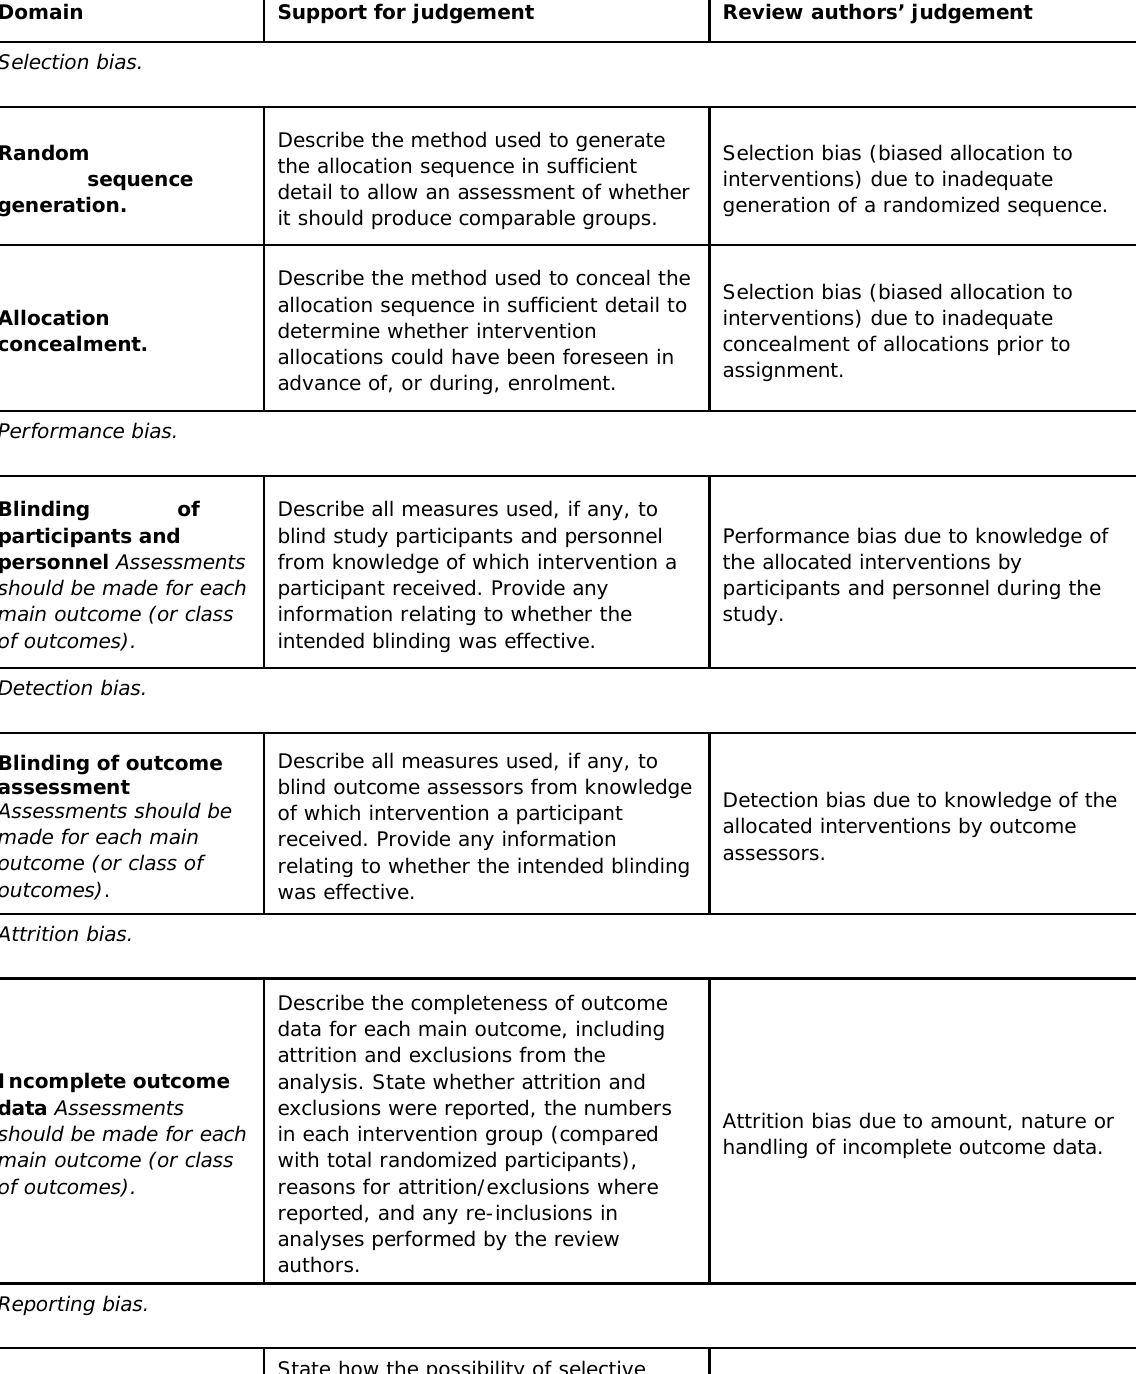
Table 2. The Cochrane collaboration tool to assess the risk of